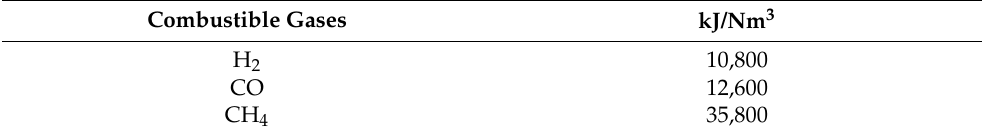
Table 4. Low heating values of the gases.